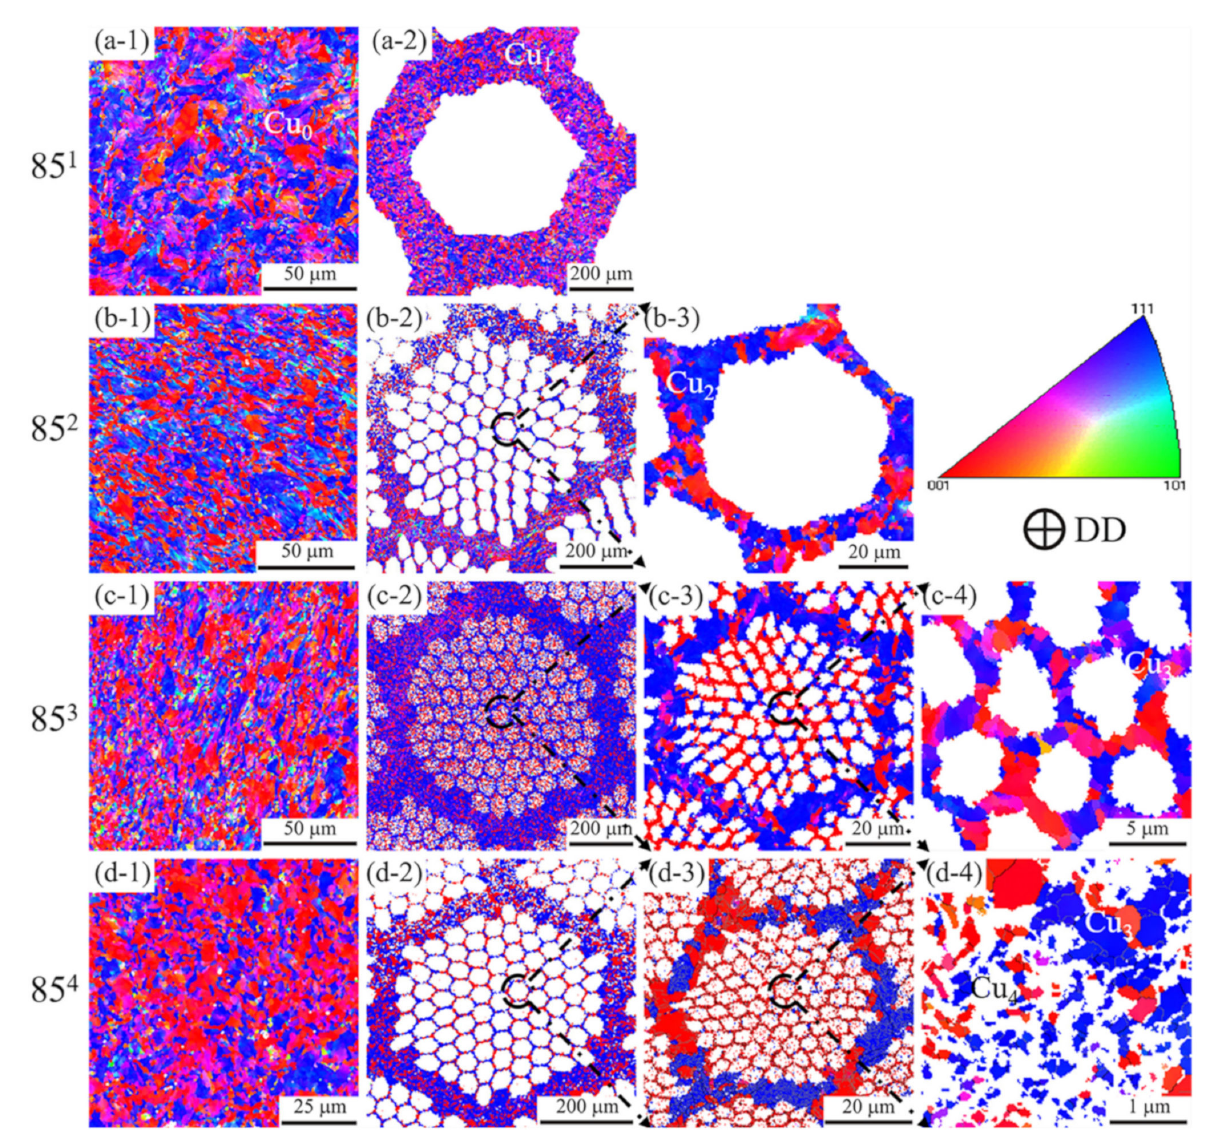
Figure 2. EBSD maps of copper matrix with different scales in different samples. ( a-1 ) Cu 0 in 85 1 ; ( a-2 ) Cu 1 in 85 1 ; ( b-1 ) Cu 0 in 85 2 ; ( b-2 ) Cu 1 in 85 2 ; ( b-3 ) Cu 2 in 85 2 ; ( c-1 ) Cu 0 in 85 3 ; ( c-2 ) Cu 1 in 85 3 ; ( c-3 ) Cu 2 in 85 3 ; ( c-4 ) Cu 3 in 85 3 ; ( d-1 ) Cu 0 in 85 4 ; ( d-2 ) Cu 1 in 85 4 ; ( d-3 ) Cu 2 in 85 4 ; ( d-4 ) Cu 3 and Cu 4 in 85 4